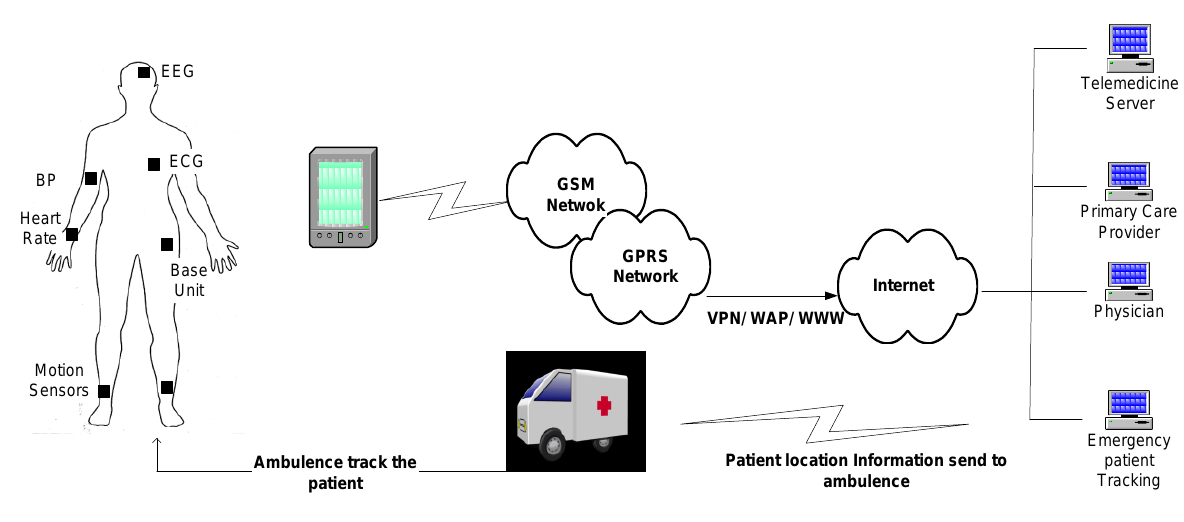
Figure 1. WBAN’s working